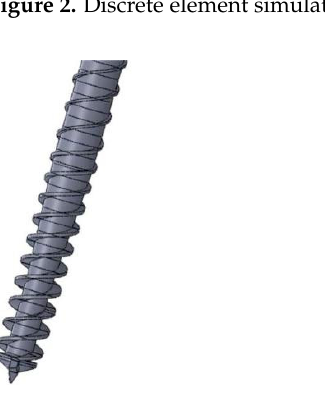
Figure 5. Selection of temperature measuring point of drill tool. 3.2. Simulated Frozen Lunar Soil The simulated lunar soil samples are composed of anorthosite and basalt with different particle sizes, as shown in Table 2. Table 2. The minerals, particle size range, and content of simulated lunar soil samples. Mineral Class @Proportion of Particle Size Range